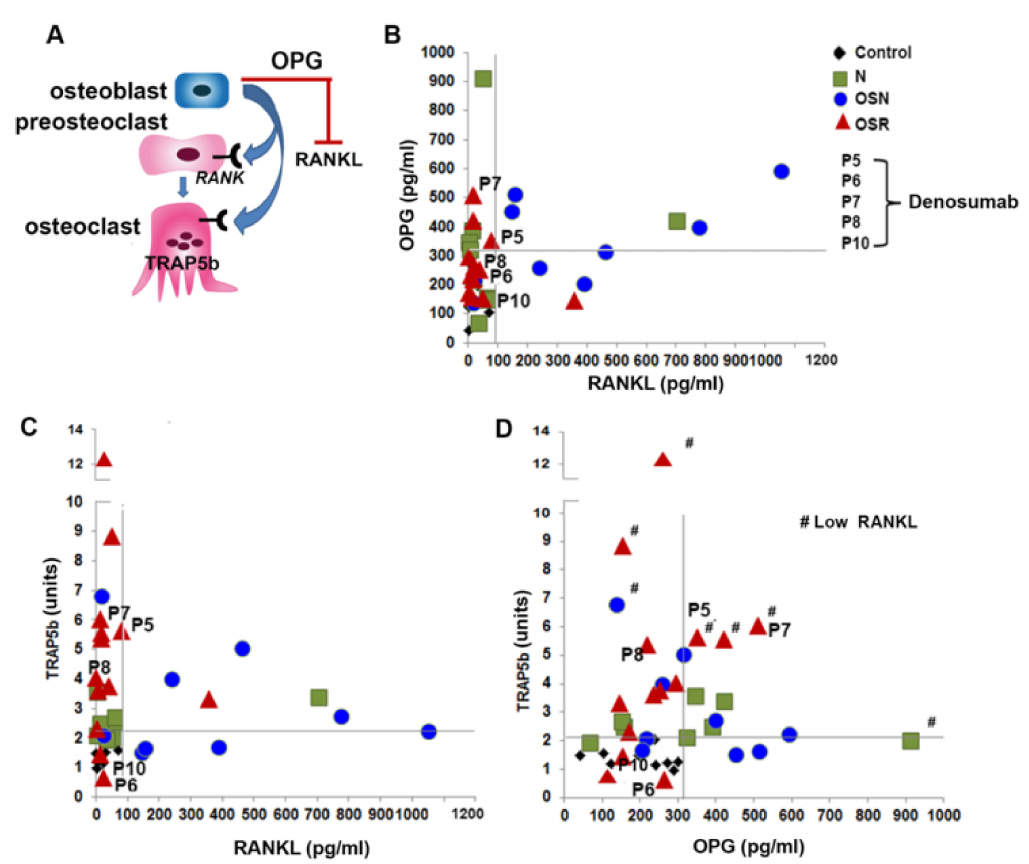
Figure 6. TRAP5b, RANKL, and OPG correlation in GD. ( A ) The RANKL-OPG-RANK pathway activates bone resorption and osteoclast differentiation. Osteoblasts express RANKL and OPG. Preosteoclasts express RANK, which is activated by RANKL. OPG neutralizes RANKL. TRAP5b, expressed by osteoclasts, is a marker of osteoclast activity. ( B – D ) Scatterplot analysis of correlation of OPG and RANKL ( B ), TRAP5n and RANKL ( C ), and TRAP5b and OPG ( D ). P5, P6, P7, P8, and P10 represent patients treated with denosumab. Healthy control (black diamond). GD cohorts: N (green), OSN (blue), and OSR (red). The graphs are divided into quadrants and demonstrate: left bottom (range of healthy controls), left top (higher than healthy control only in the vertical axis), right bottom (higher than healthy control only in the horizontal axis), and right top (higher than healthy control in both the vertical and the horizontal